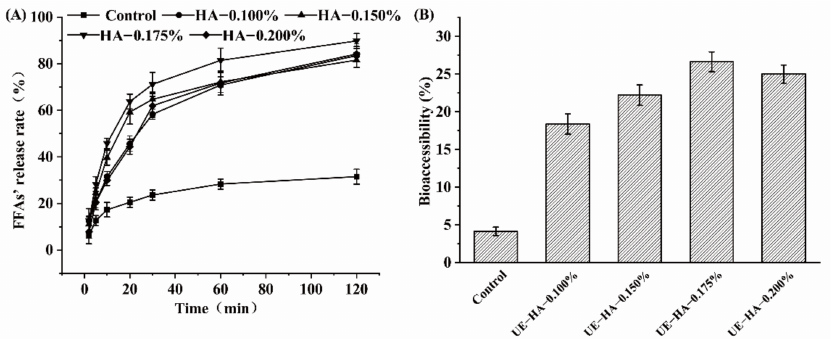
Figure 6. The amount of FFA released from the HA- β -carotene emulsion and the control group in the SIDP ( A ); influence of different emulsification methods on the bioaccessibility (%) of in vitro digestion ( B